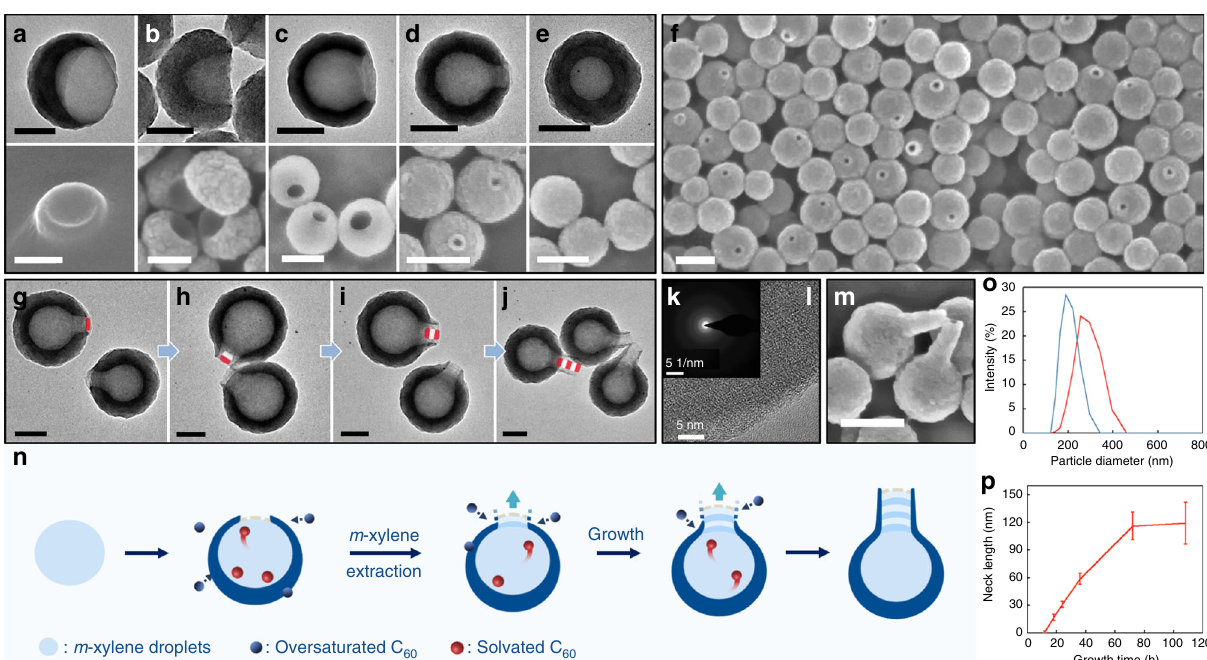
Fig. 2 Morphological control of C 60 nanobowls and bottles. a – e TEM images (top row) of typical C 60 nanobowls with decreasing opening size and their corresponding scanning electron microscope (SEM) images (bottom row). f Large area SEM image of nanobowls with ~40 nm opening. g – j TEM images of nanobottles incubated for 18, 24, 36, and 72 h, respectively. k , l SAED and HR-TEM image of the nanobowl. m SEM image of nanobottles incubated for 72 h. n Schematics illustrating the formation of the nanobottles. o DLS measurement of particle size distribution of nanobottles incubated for 18 h (blue) and 72 h (red). p Dependence of nanobottles ’ neck length on incubation time; error bars indicating standard deviation. Scale bars are 100 nm for TEM images (the top row of a – e , and g – j ), and 200 nm for SEM images (the bottom row of a – e , f , and m